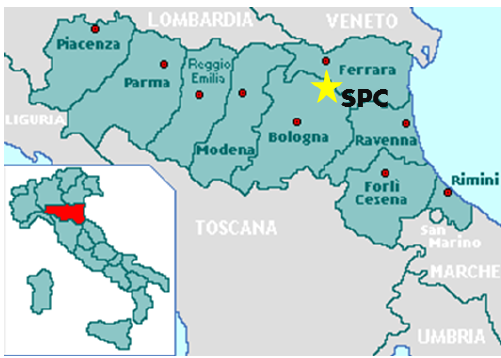
Figure 1. Location of the ground station San Pietro Capofi- ume (SPC) in Italy (adapted from http://www.italyworldclub.com/ emilia/). The region Emilia Romagna is highlighted showing the main cities in the area. In the lower left corner its position within Italy is